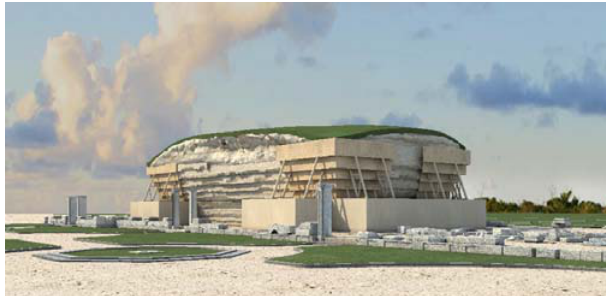
Figure 9. Effect drawing for the holder